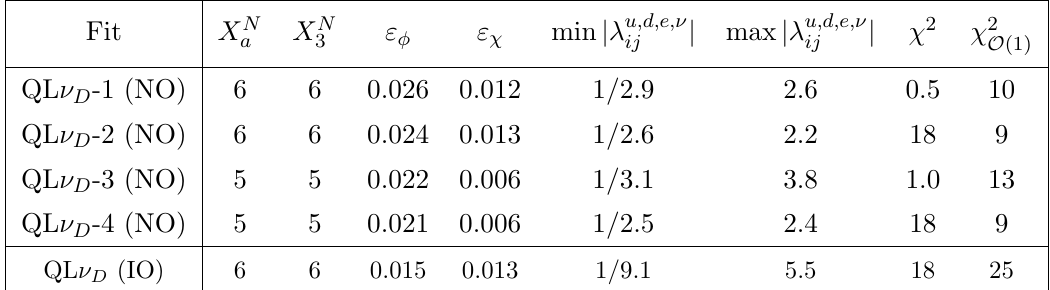
Table 6 . Best (cid:12)ts of the combined quark and lepton sector including CKM phase and Dirac neutrinos, with normal ordering (NO) or inverted ordering (IO). The complete set of parameters can be found in table